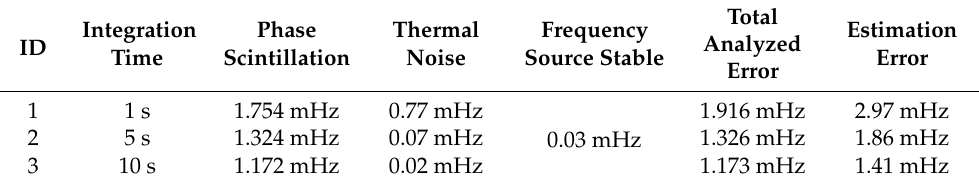
Table 3. The comparison of estimation error and total analyzed error at JM